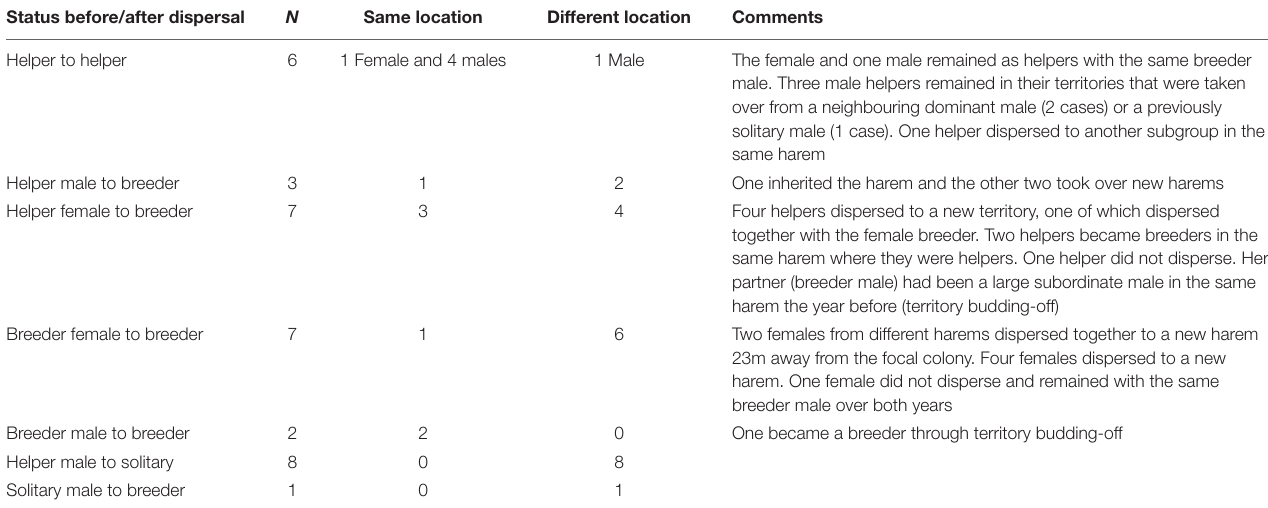
TABLE 3 | Re-captures and dispersal events recorded between